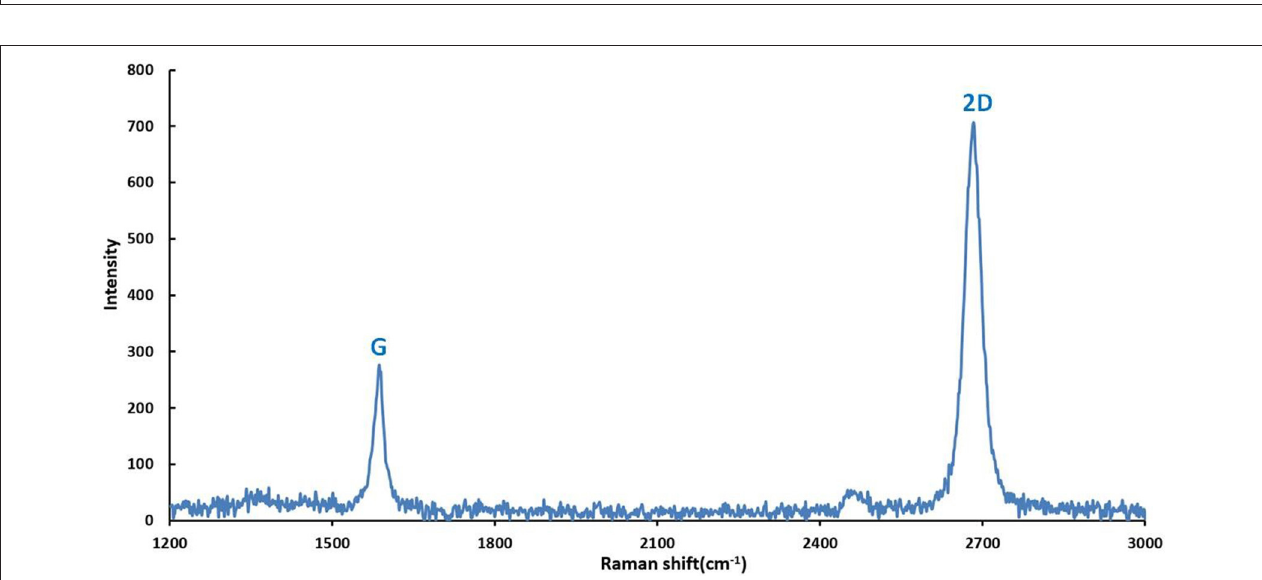
FIGURE 4 | Raman spectrum (514.5nm laser wavelength) obtained from the graphene film on the sensor showing the G peak and 2D band features characteristic for single-layer graphene (I2D/IG = 2.67).